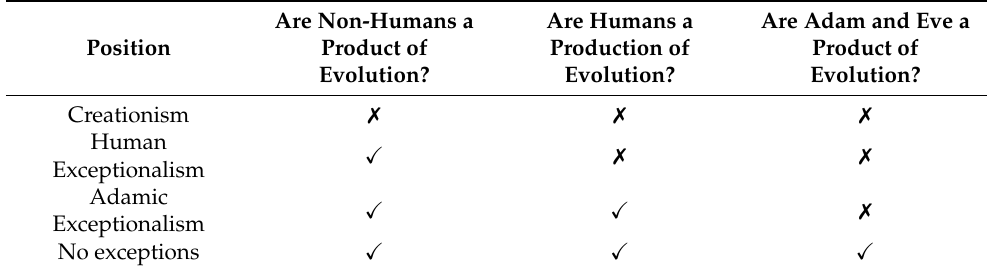
Table 2. Classification for Islam and